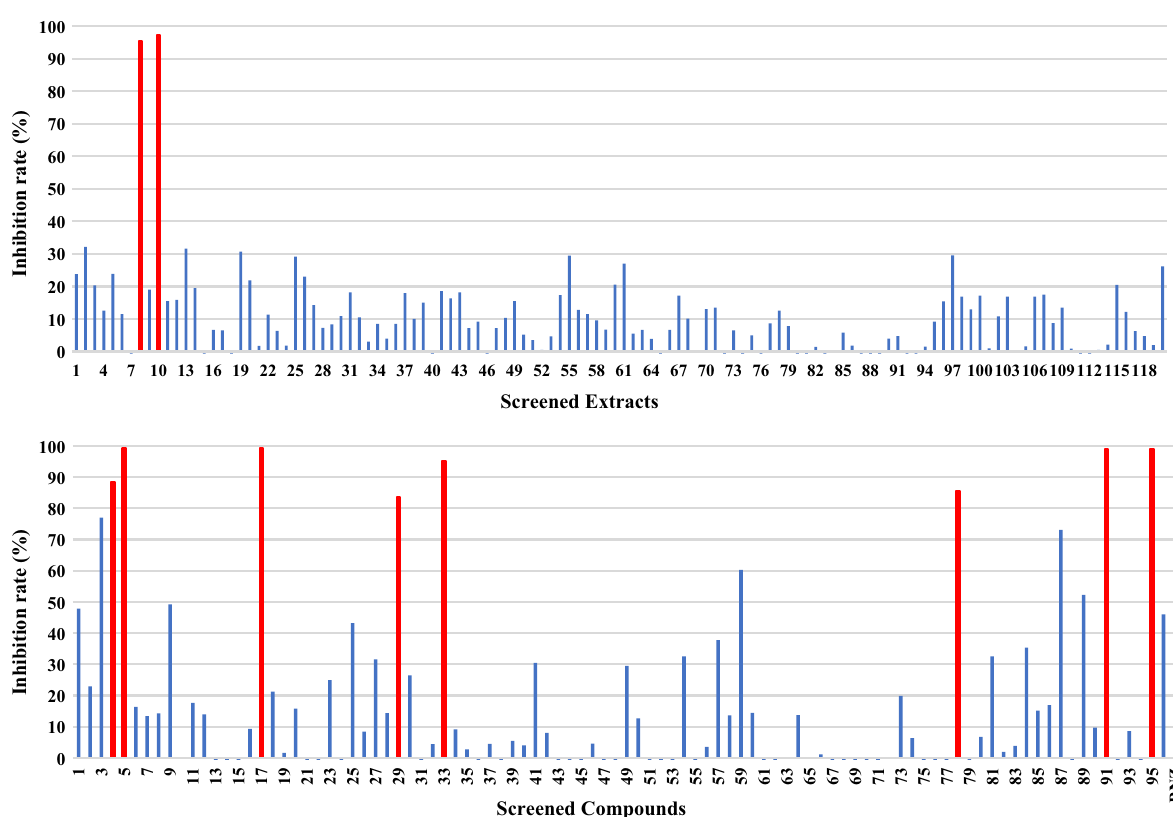
Fig. 1 Screen of 120 kinds of extracts (20 μg/ml) and 94 kinds of compounds (20 μM) isolated from medicinal herbs by luminescence intensity to evaluate inhibitory effect. Data are presented as percent reduction in intensity. Experiments were done in